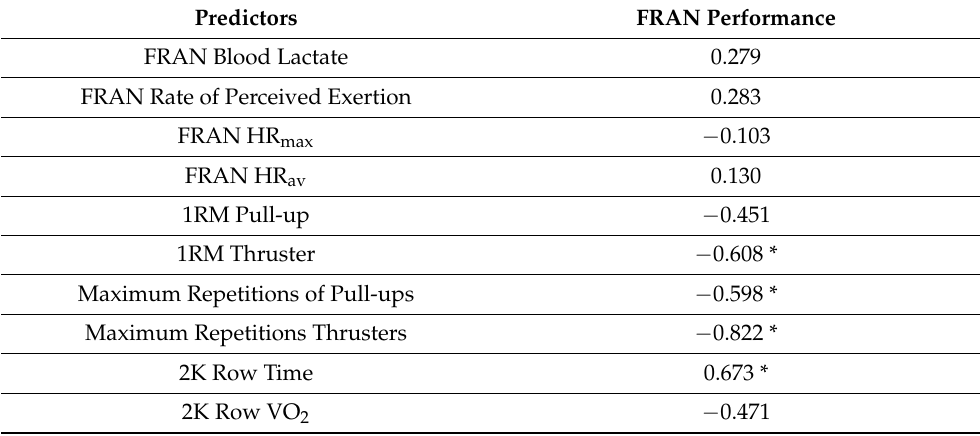
Figure 2. Predictors of FRAN. Correlation between FRAN and ( A ) thruster 1RM (kg); ( B ) thruster maximum repetitions; ( C ) 2K time; and ( D ) pull-up maximum repetitions; a p < 0.05 for correlation. Table 2. Spearman’s correlation of FRAN with Performance Tests for the Prediction of